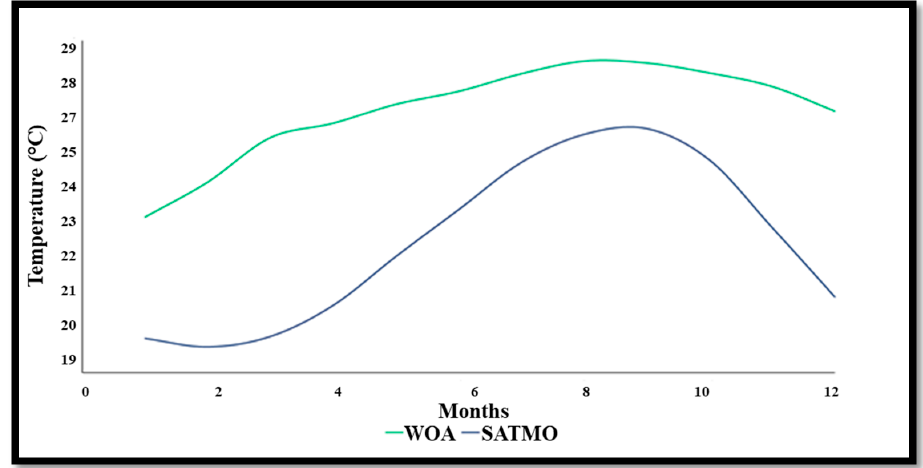
Figure 4. Comparison of the average monthly SST data, 2002–2017, for two databases for the Mexican Pacific Ocean.